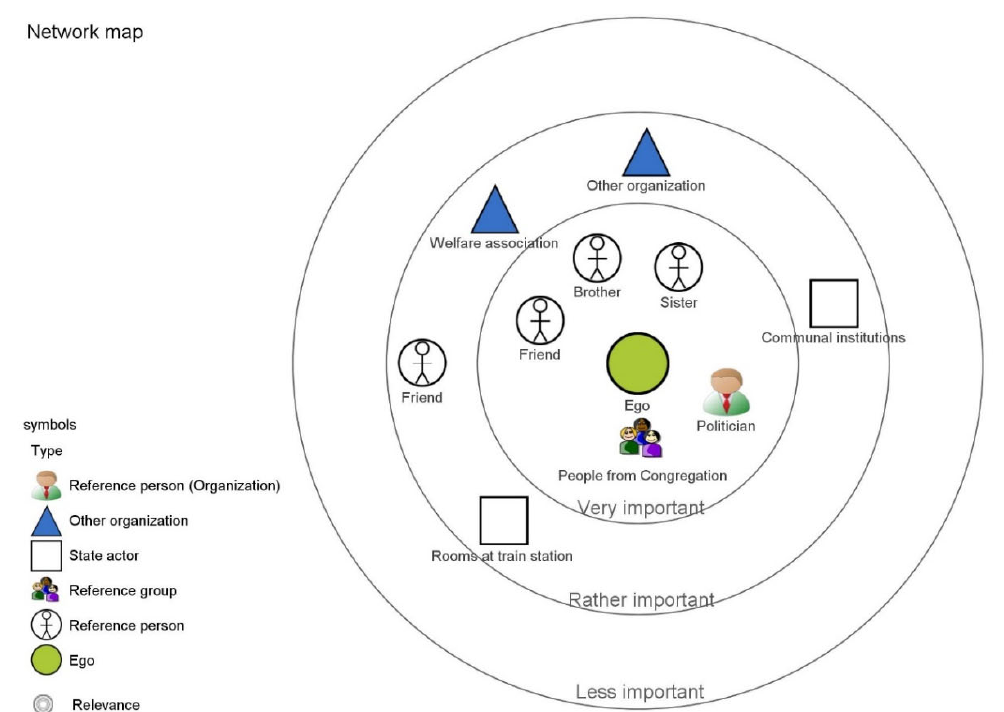
Figure 1. Orhan’s egocentric network chart